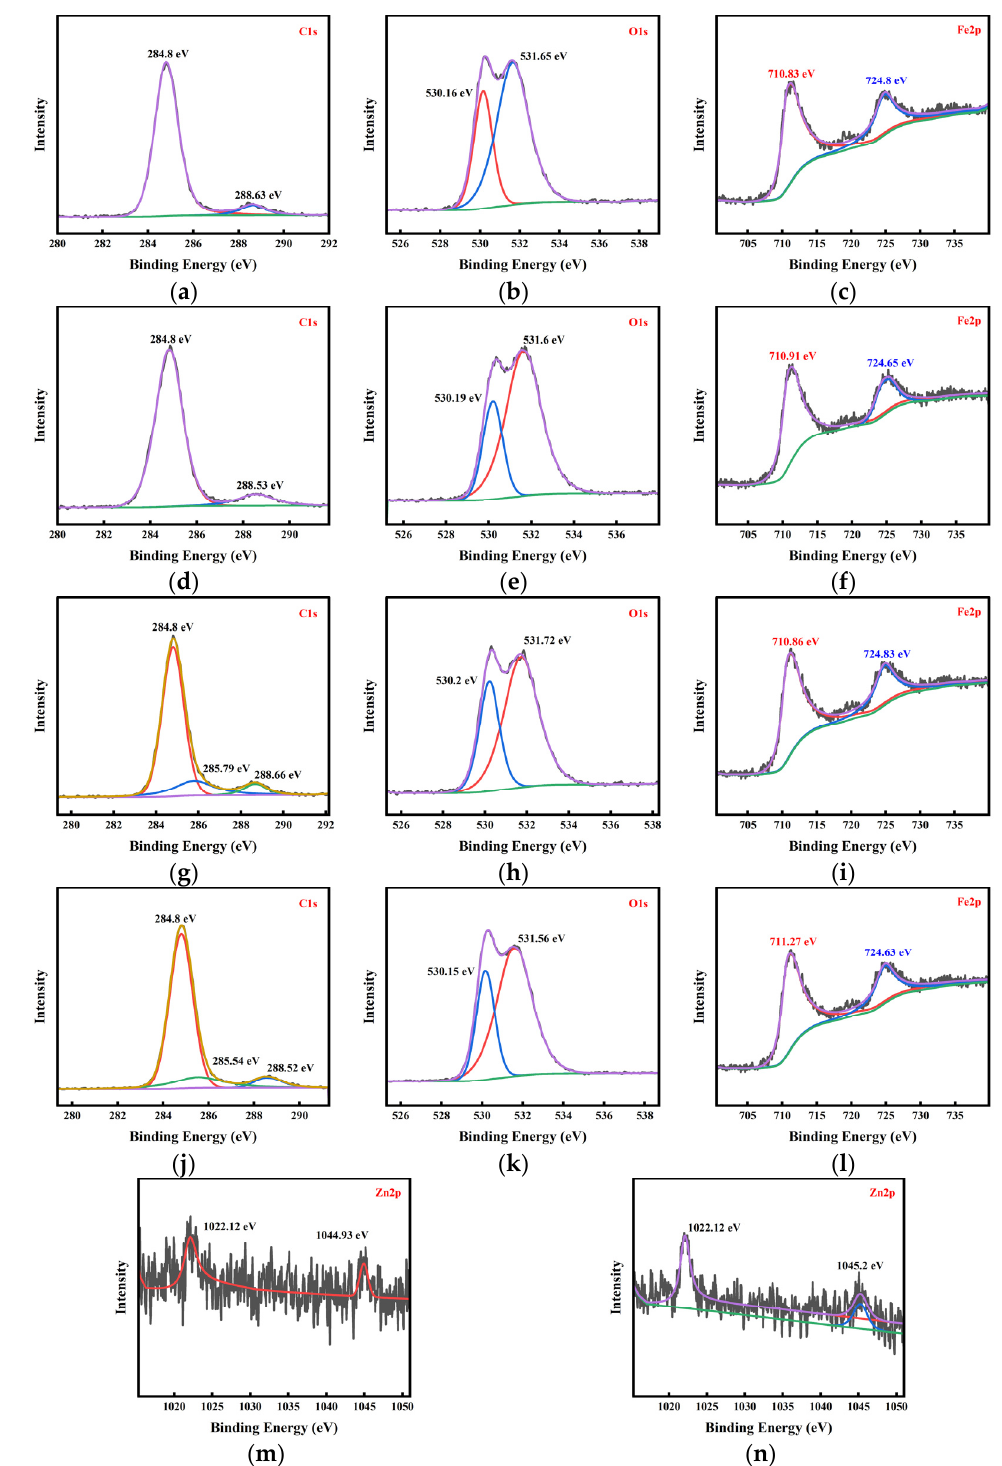
Figure 10. XPS diagram of wear scars ( a – c ) 10 # WO; ( d – f ) FS; ( g – i , m ) ZnFe-LDH; ( j – l , n ) FS/ZnFe-LDH.